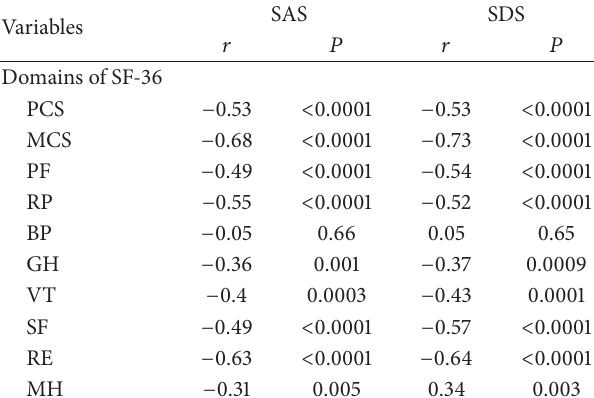
Table 2: Correlations between psychological scores, disease param- eters, and quality of life in SLE